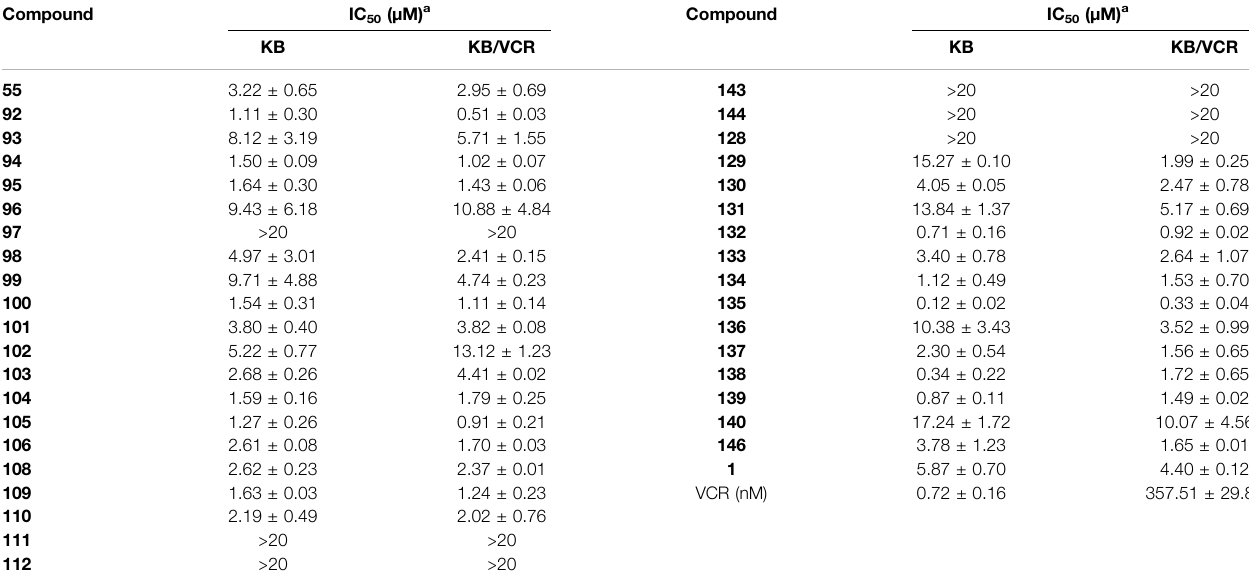
TABLE 3 | Antiproliferative effects of tanshinone I derivatives ( 55 , 92 – 106 , 108 – 112 , 128 – 140 , 143 – 144 , and 146 ) on human cancer cell lines.